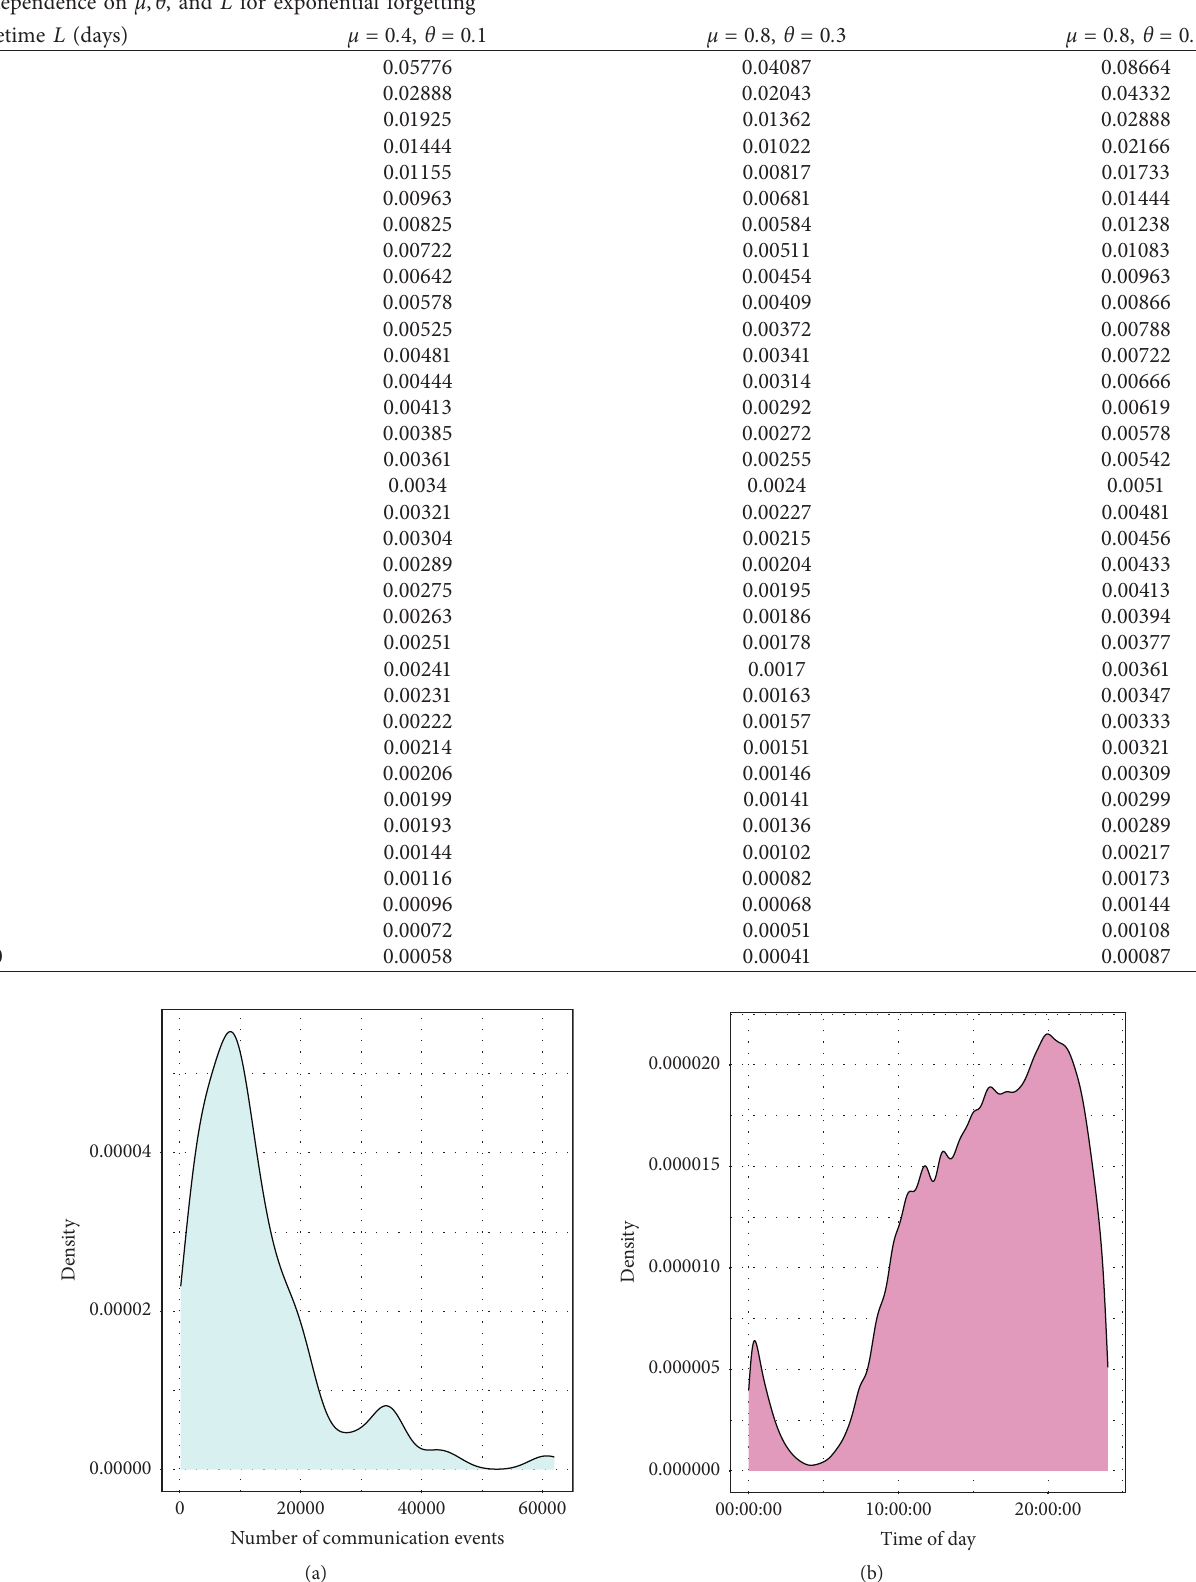
Table 3: Setting of parameters for exponential forgetting function in computational